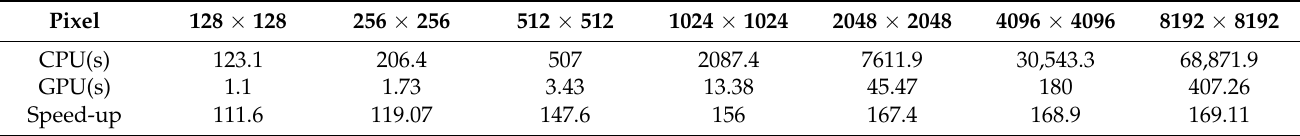
Table 4. Simulation time (s) comparison in generating different